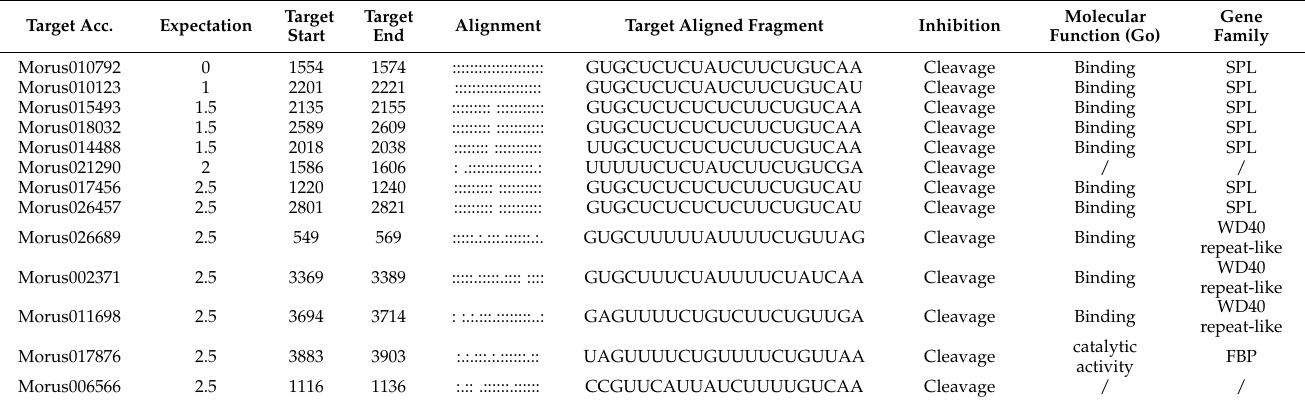
Figure 2. Gene ontology analysis of the predicted target genes of miR156 in mulberry. Table 2. Predicted target genes of miR156 in mulberry (Expectation ≤